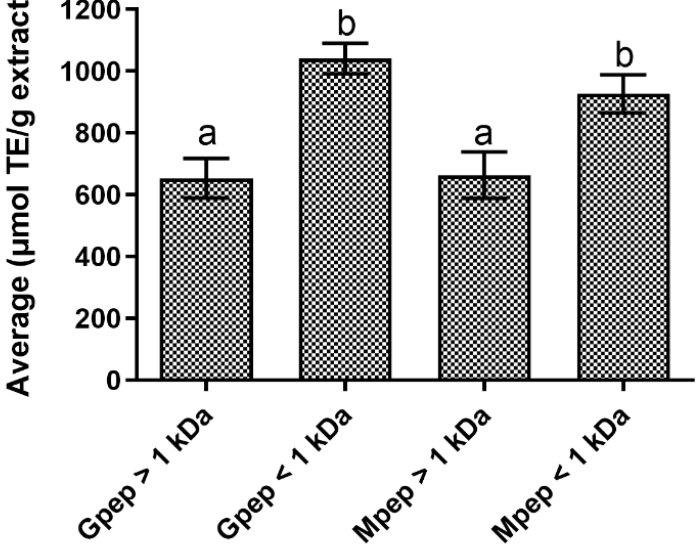
Figure 1. Peptide fractions antioxidant activity according to the ORAC assay. Different letters rep- resent the statistically significant ( p < 0.05) differences found between the tested samples at the tested concentration.